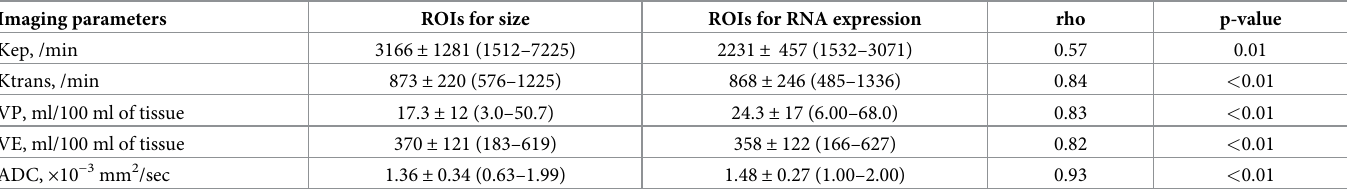
Table 3. The correlations between ROIs for size and ROIs for RNA expression and the perfusion parameters and ADC. Imaging parameters ROIs for size ROIs for RNA expression rho p-value Kep, /min 3166 ± 1281 (1512–7225) Ktrans, /min VP, ml/100 ml of tissue VE, ml/100 ml of